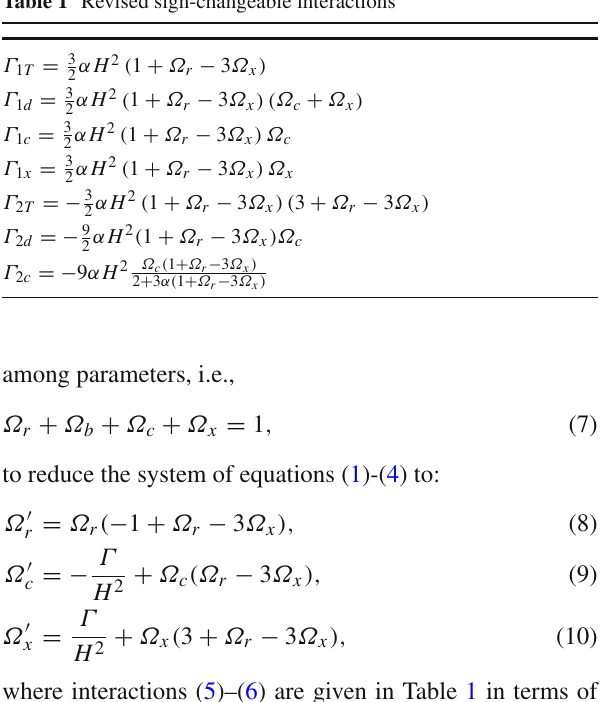
Table 1 Revised sign-changeable